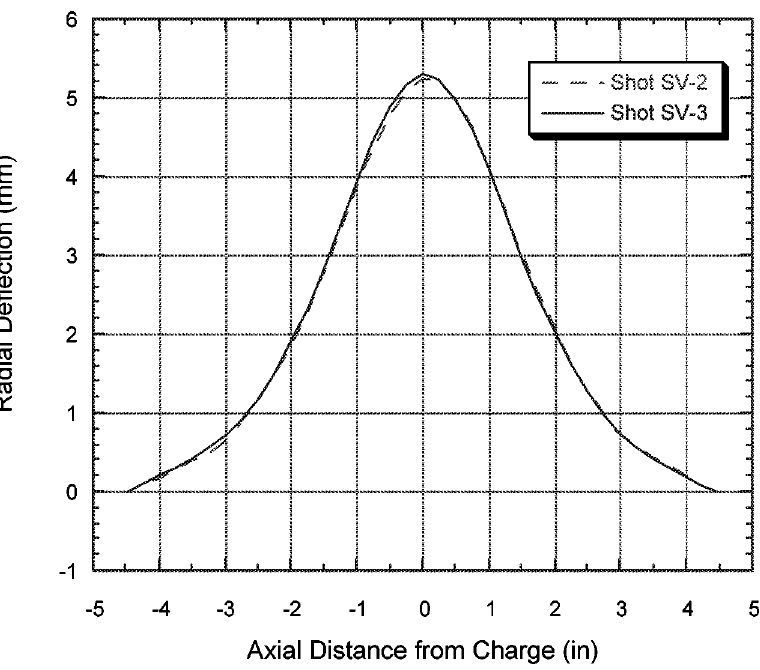
Fig. 4. Comparison of final wall deformation along the 0 (cid:14) side for replicated experiments, Shots SV-2 and SV-3. approximately twice the final deformation of the cylin- der in Shot SV-3, in proportion to the charge masses. Wall thicknesses at the midplane and tube heights measured before and after the shots Shot Wall thickness